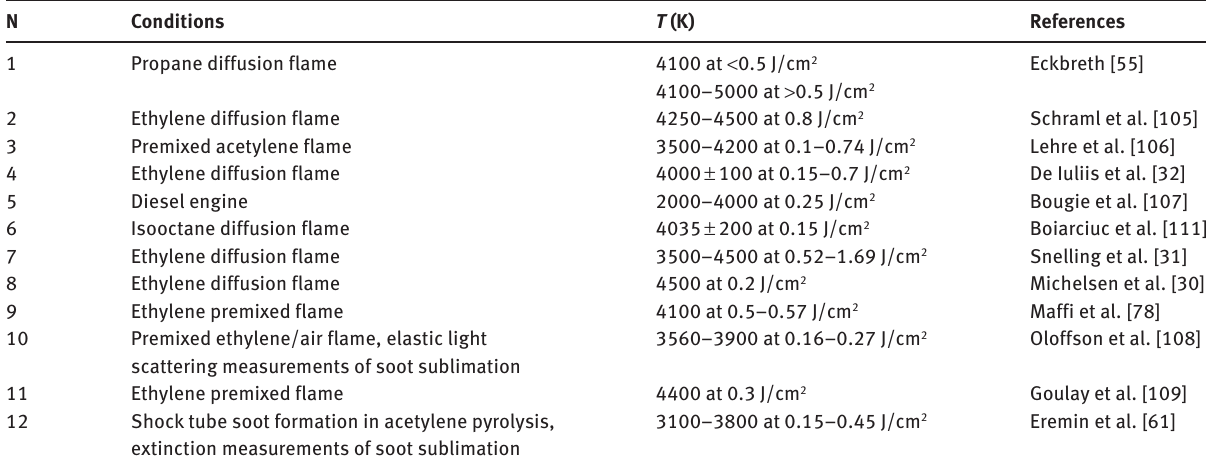
Table 3: The soot particle peak temperatures measured by pulsed laser